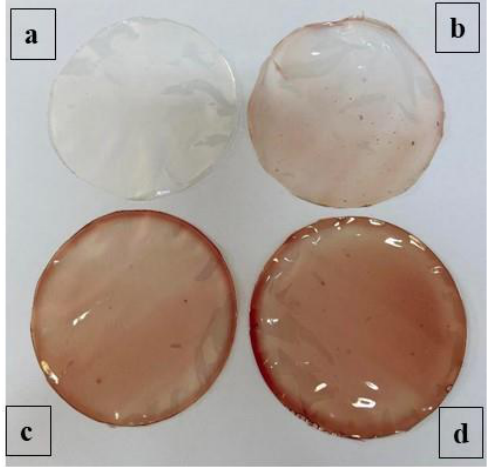
Figure 2. Visual aspects of ( a ) control (0%), ( b ) 1-BPE (0.25%), ( c ) 2-BPE (0.5%), and ( d ) 4-BPE (1%) films.